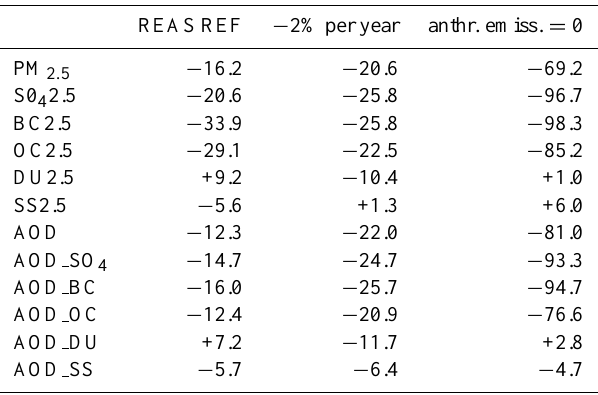
Table 3. Percentage changes of mass concentration and AOD of dif- ferent aerosol species in China. Change from simulation of present- day Asia in the different scenarios. REAS REF − 2% per year anthr. emiss. =